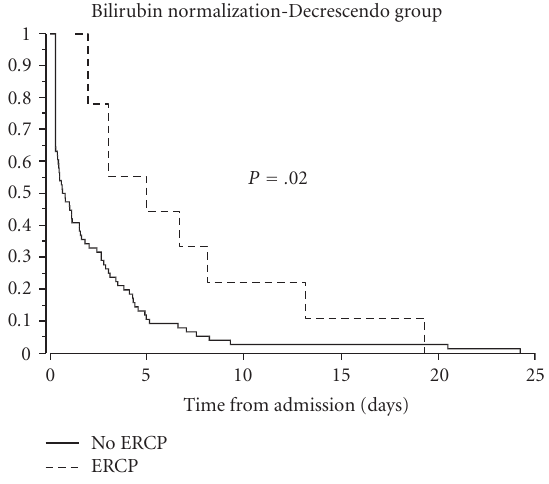
Figure 4: Kaplan Meier Plot of Time to Normalization ( < 1.0mg/dL) of bilirubin in the Crescendo-Decrescendo group. In patients not undergoing ERCP, time 0 was the time of admission, which corresponded to the highest bilirubin level for that patient. In patients undergoing ERCP, time 0 was the day of the ERCP and time to normalization was calculated from the time of ERCP. Time to normalization in patients undergoing ERCP was significantly delayed ( P = .